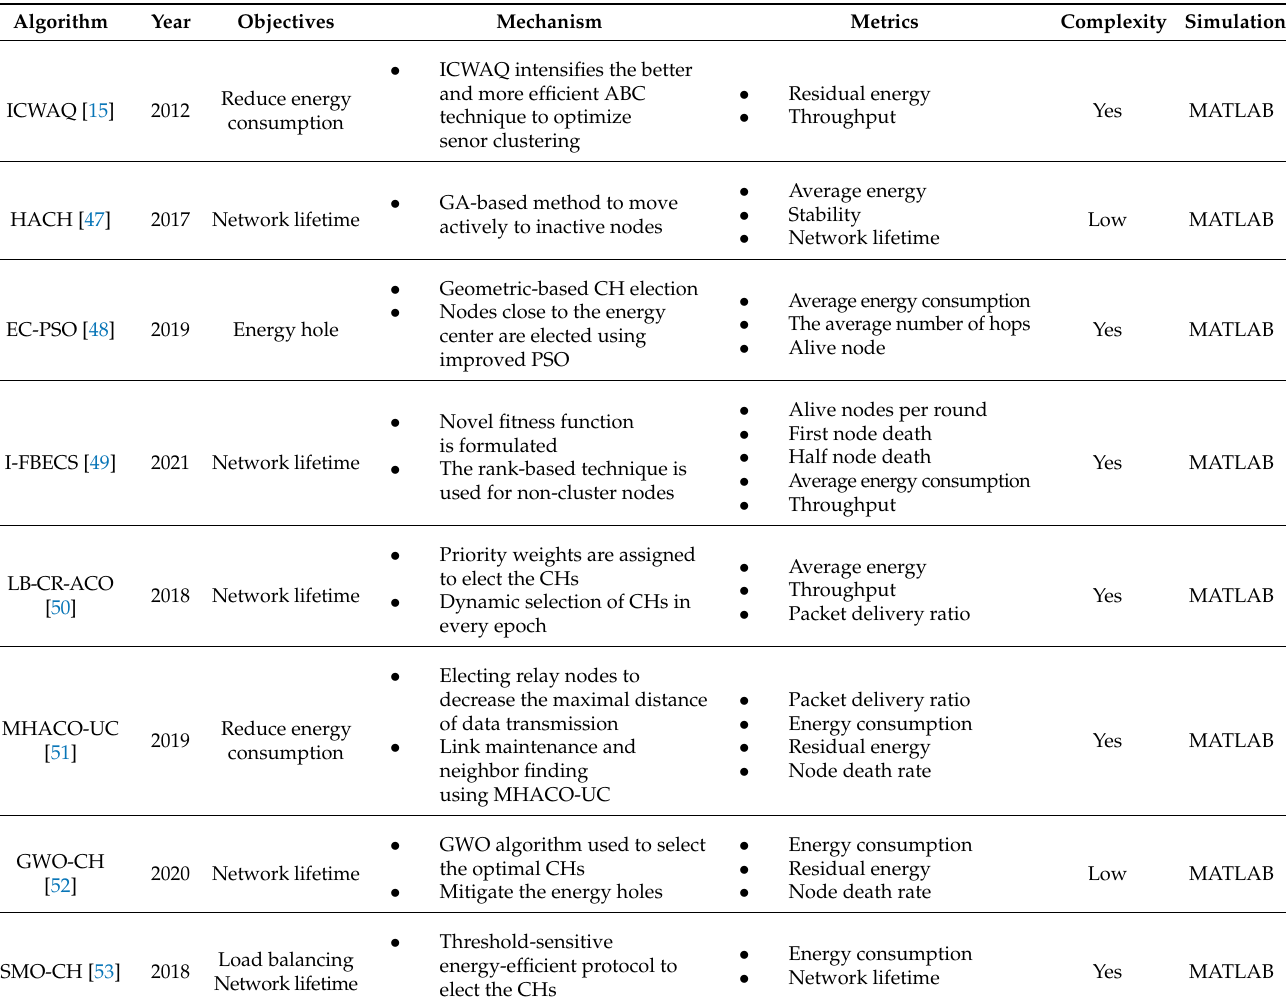
Table 2. Review of metaheuristics-based clustering